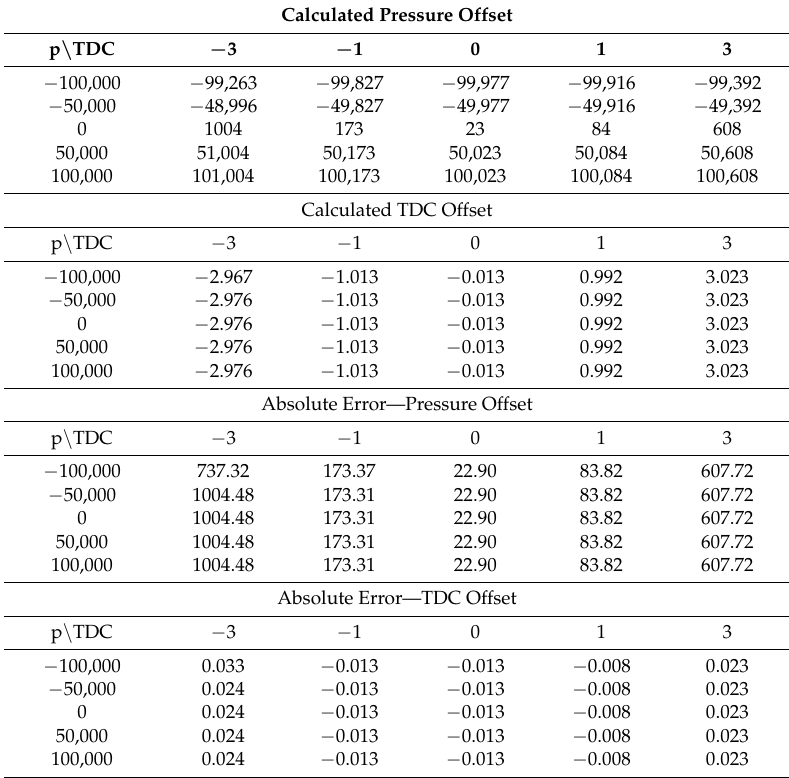
Table B3. Calculated pressure and TDC offsets and their absolute errors for the PSA engine and operating point 2000 1/min and 20 Nm using the off-line